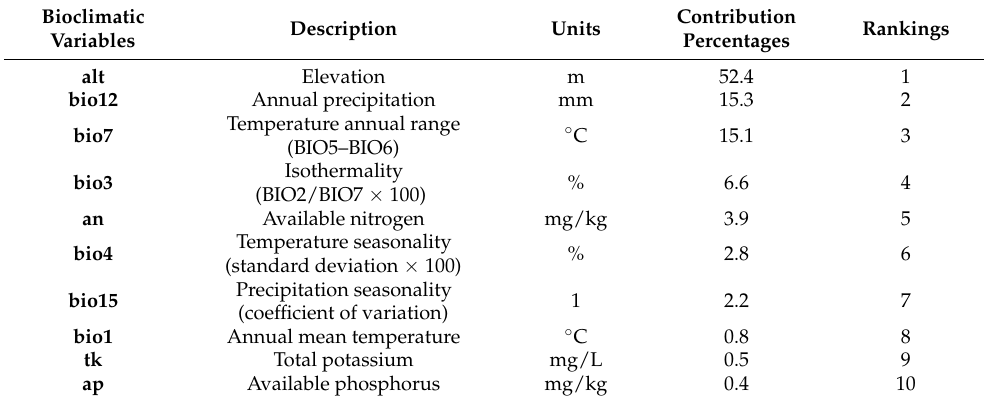
Table 1. The contribution proportions and cumulative proportion contributions of the top 10 indica- tors in principle component analysis (PCA).